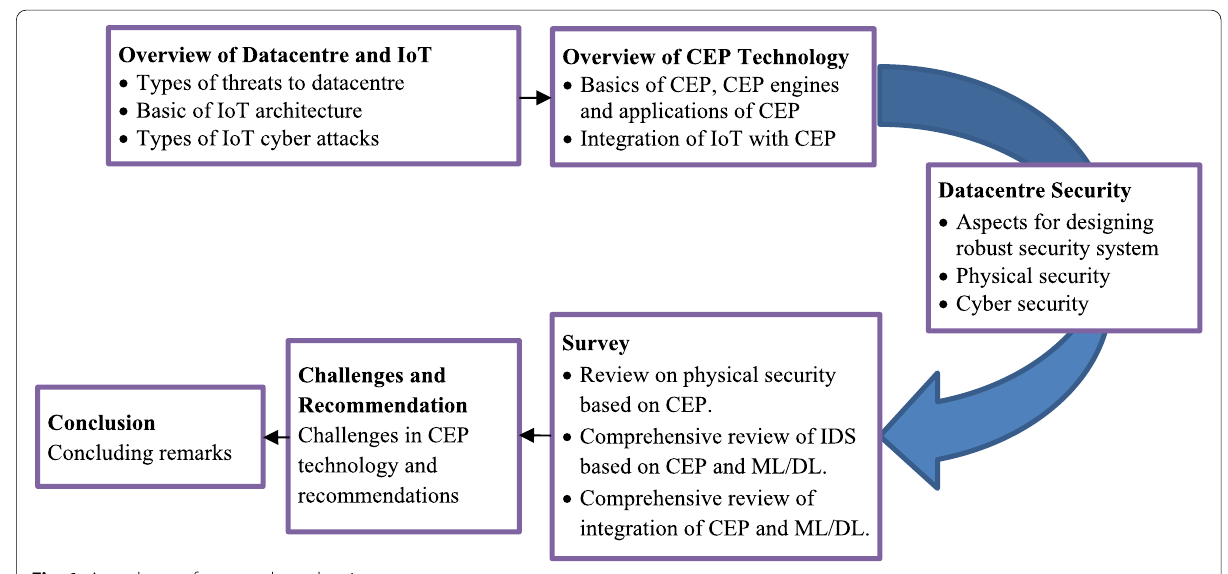
Fig. 1 A roadmap of our conducted review